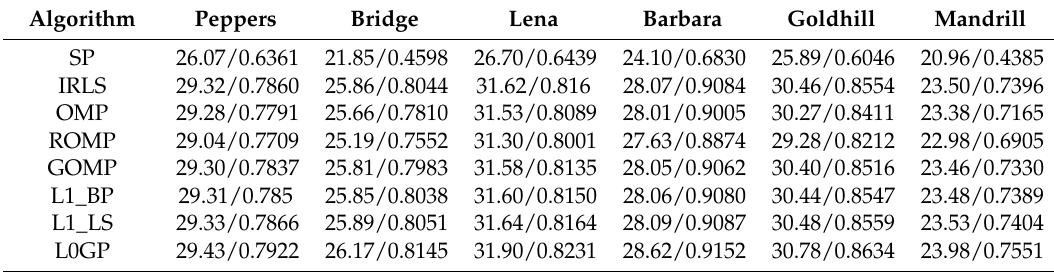
Table 4. The quantitative results (PSNR/SSIM) of different algorithms for the different types of